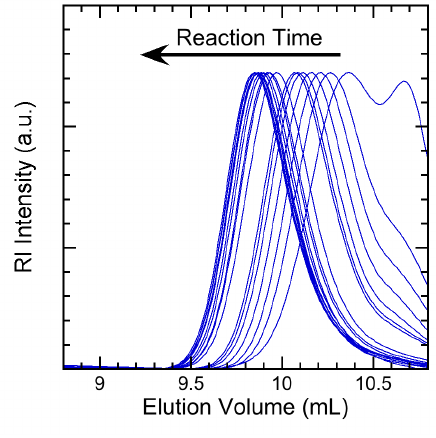
Figure A1. SEC profiles for PMMA-2 vs. time (normalized intensity